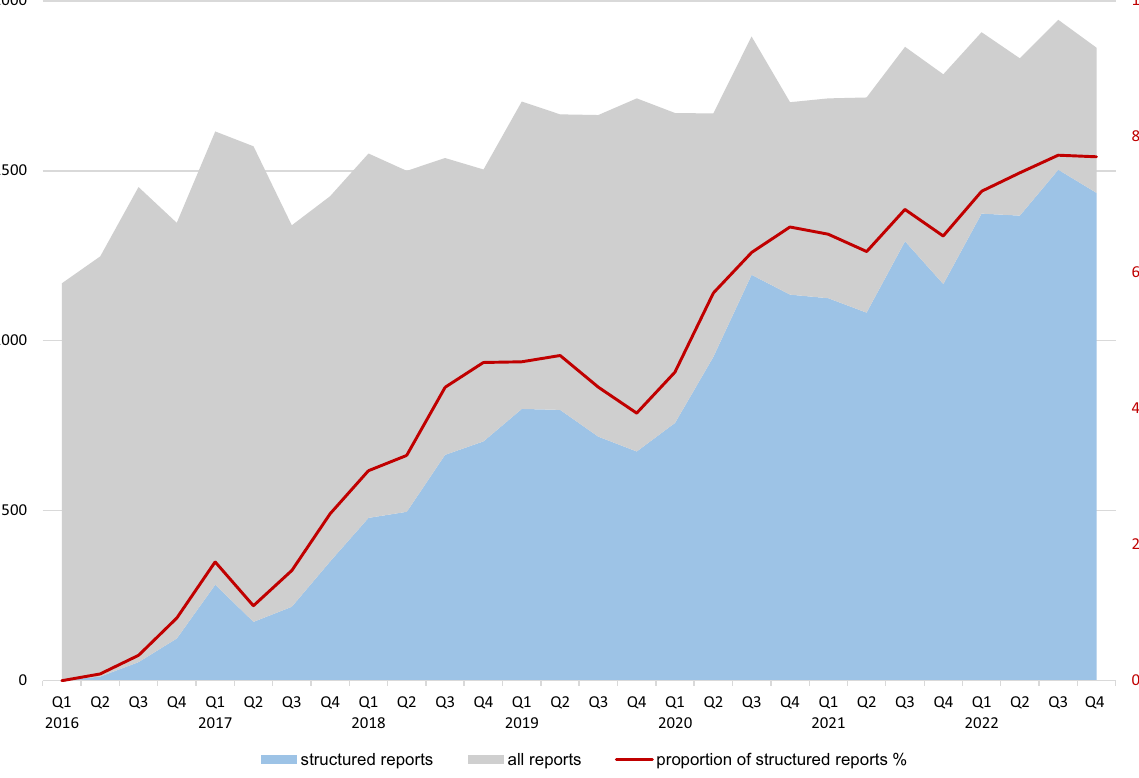
Fig. 2 Absolute numbers of all radiological reports (grey) and structured reports (blue) as well as the proportion of structured reports (red) over a 7-year period on a quarterly basis for the ten most frequently used